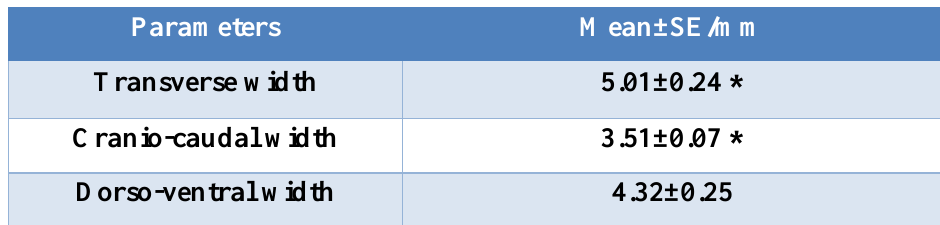
Table, 4: Shows the transverse, cranio-caudal and dorso-ventral widths of the